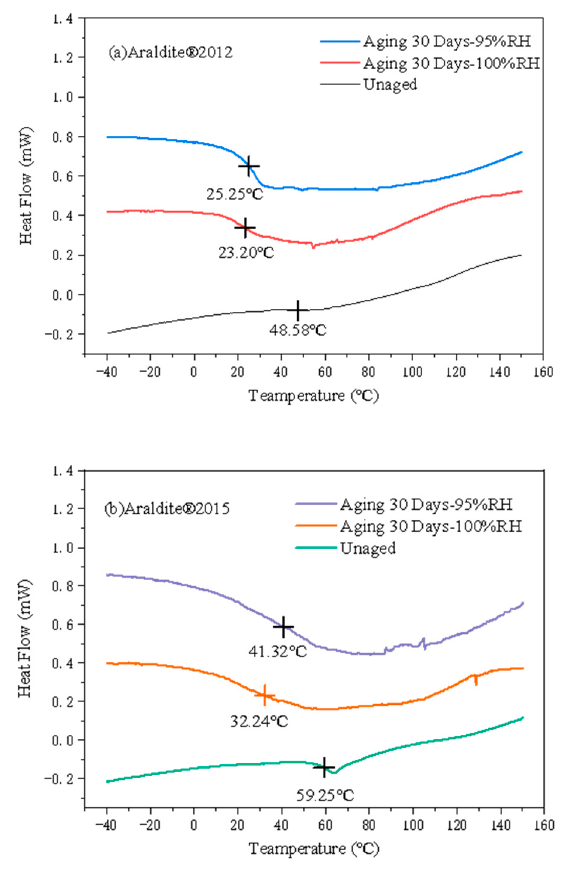
Figure 11. Representative DSC results and average Tg assignment of adhesive: ( a ) A2012 and ( b )